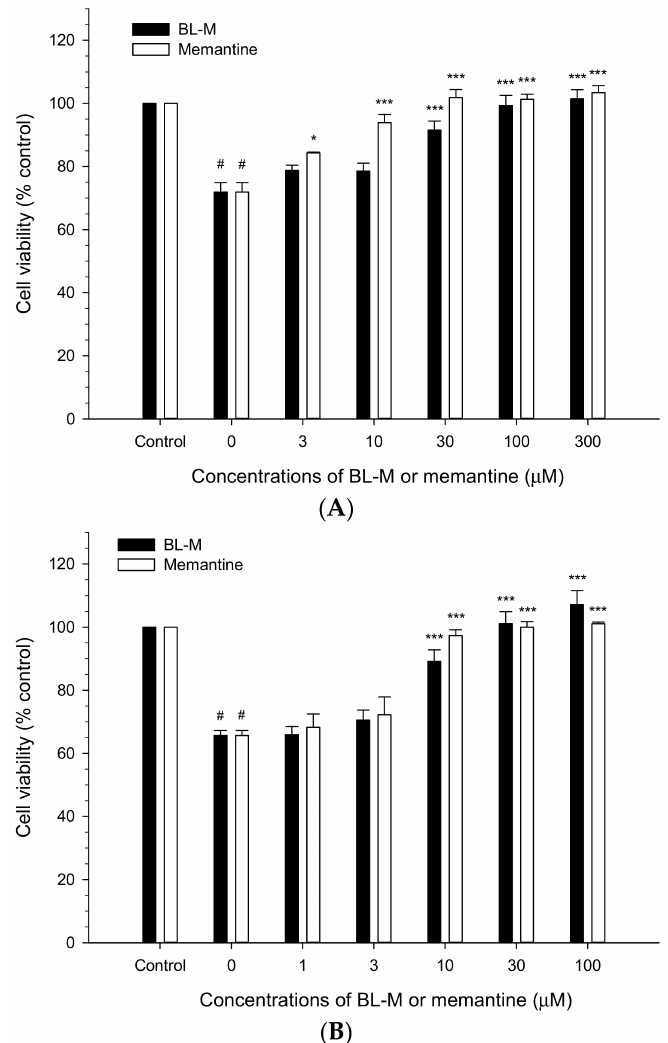
Figure 2. Neuroprotective effects of BL-M and memantine on Glu- or N -methyl- D -aspartate (NMDA)-induced excitotoxic neuronal cell death in the primary cultured rat cortical cells. The cultured cells (10–11 days in vitro) were exposed to 100 µ M Glu ( A ) or 300 µ M NMDA ( B ) for 15 min in the absence or presence of the indicated concentrations of BL-M or memantine, as described in the Section 4. Cell viability was assessed using the MTT reduction assays followed by 22–24 h incubation at 37 ◦ C after the exposure, and expressed as % of control-treated cells (# p < 0.001 vs. control; * p < 0.05, *** p < 0.001 vs. Glu- or NMDA-treated cells, respectively). Each data represents the mean ± S.E.M. from at least three independent